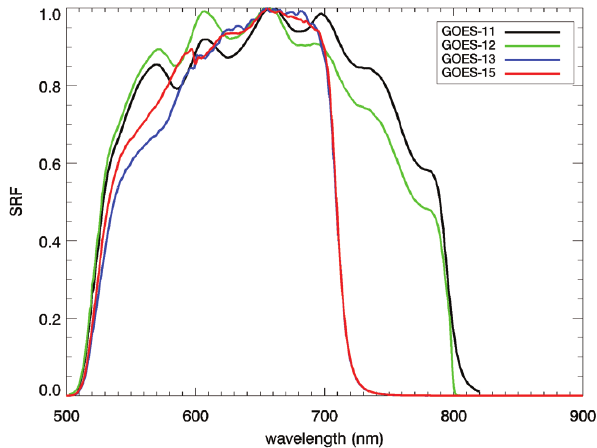
Fig. 4. Spectral response functions of the visible channels of the four GOES satellites (ASPB and CIMSS Calibration Projects and Research,